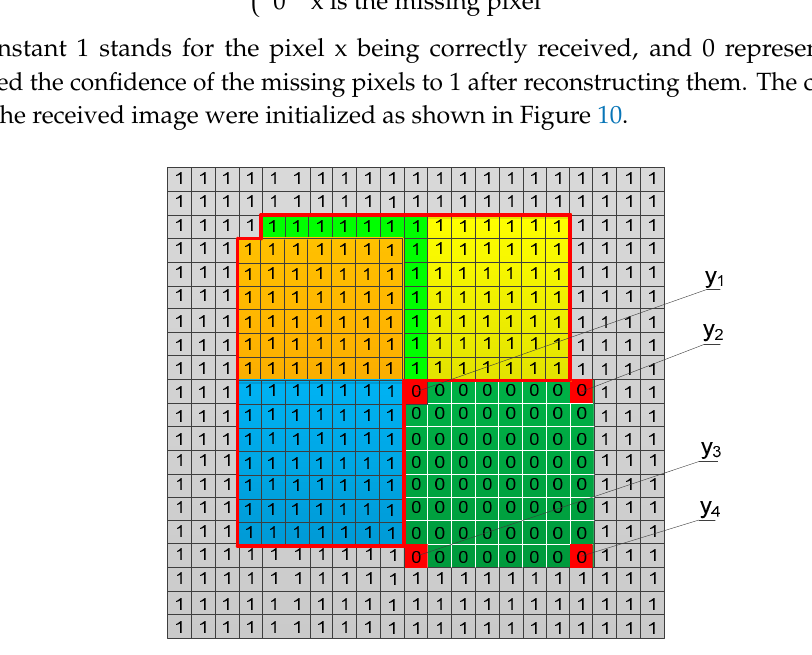
Figure 10. The initialization confidence of pixels in the received image. Each square stands for one pixel. The gray pixels with label 1 represent the correctly received pixels, while the green ones with label 0 are the missing pixels. The red pixels are the currently being filled. The part in the red box is the support areas of the missing pixel y 1 1